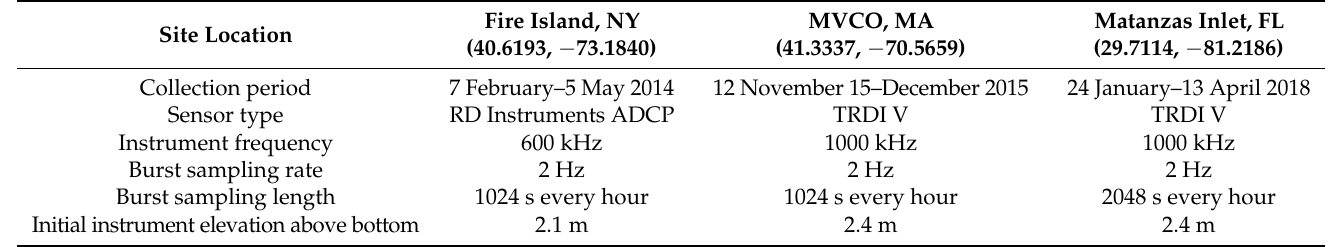
Table 2. ADCP sensor specifications for the three sites. The sensor height for the velocity mea- surements changed during the deployment period but the median elevation remained around the nominal elevation (latitude and longitude in decimal